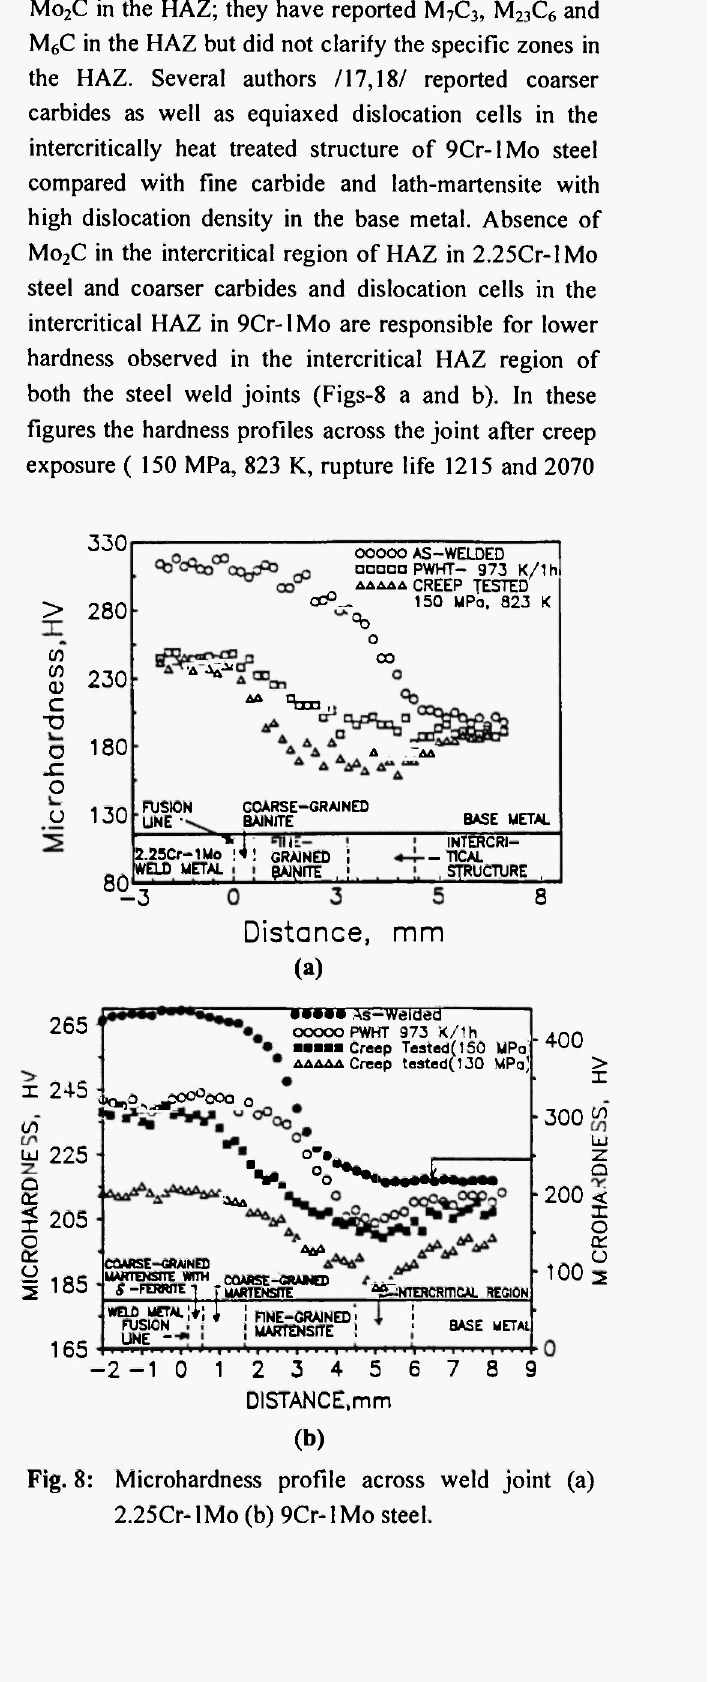
Fig. 8: Microhardness profile across weld joint (a) 2.25Cr-lMo (b) 9Cr-lMo